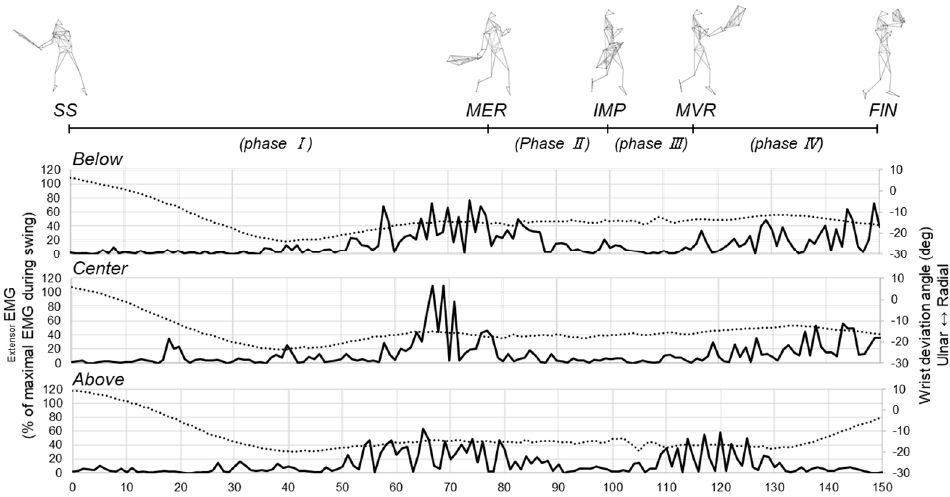
Figure 2. Phases of swing motion, changes in wrist extensor electromyography (EMG; solid line) and wrist ulnar/radial deviation angle (dotted line) in three impact location patterns categorized below, above or on (Center) the longitudinal axis. Data were from one selected subject. SS, start swing; MER, maximal shoulder external rotation; IMP, ball impact; MVR, maximal velocity during recovery phase; FIN, finish swing.